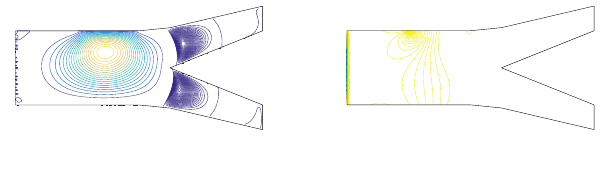
Figure 8. Computed streamlines(left) and pressure contours(right) for blood flow at ν = 0 . 1.